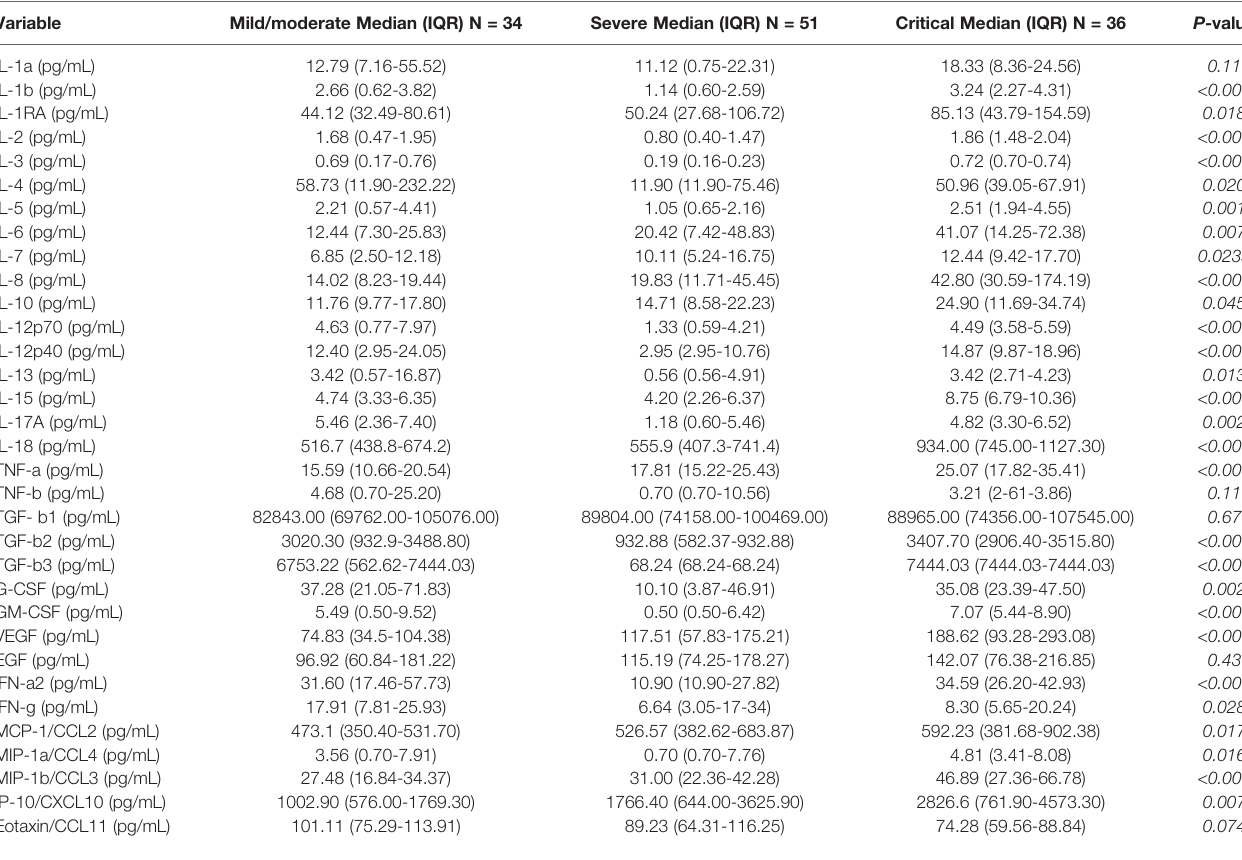
TABLE 3 | Serum Cytokines and chemokines from COVID-19 according to disease severity.